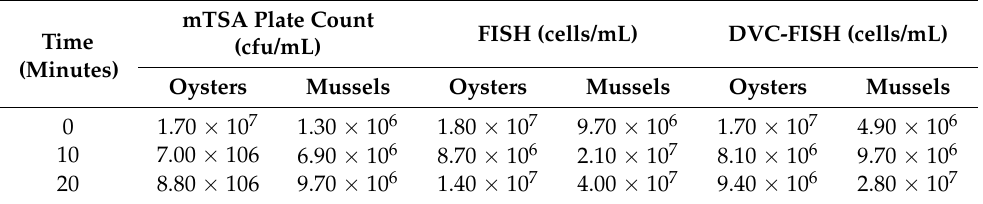
Table 2. Counts of oyster and mussel samples in transport